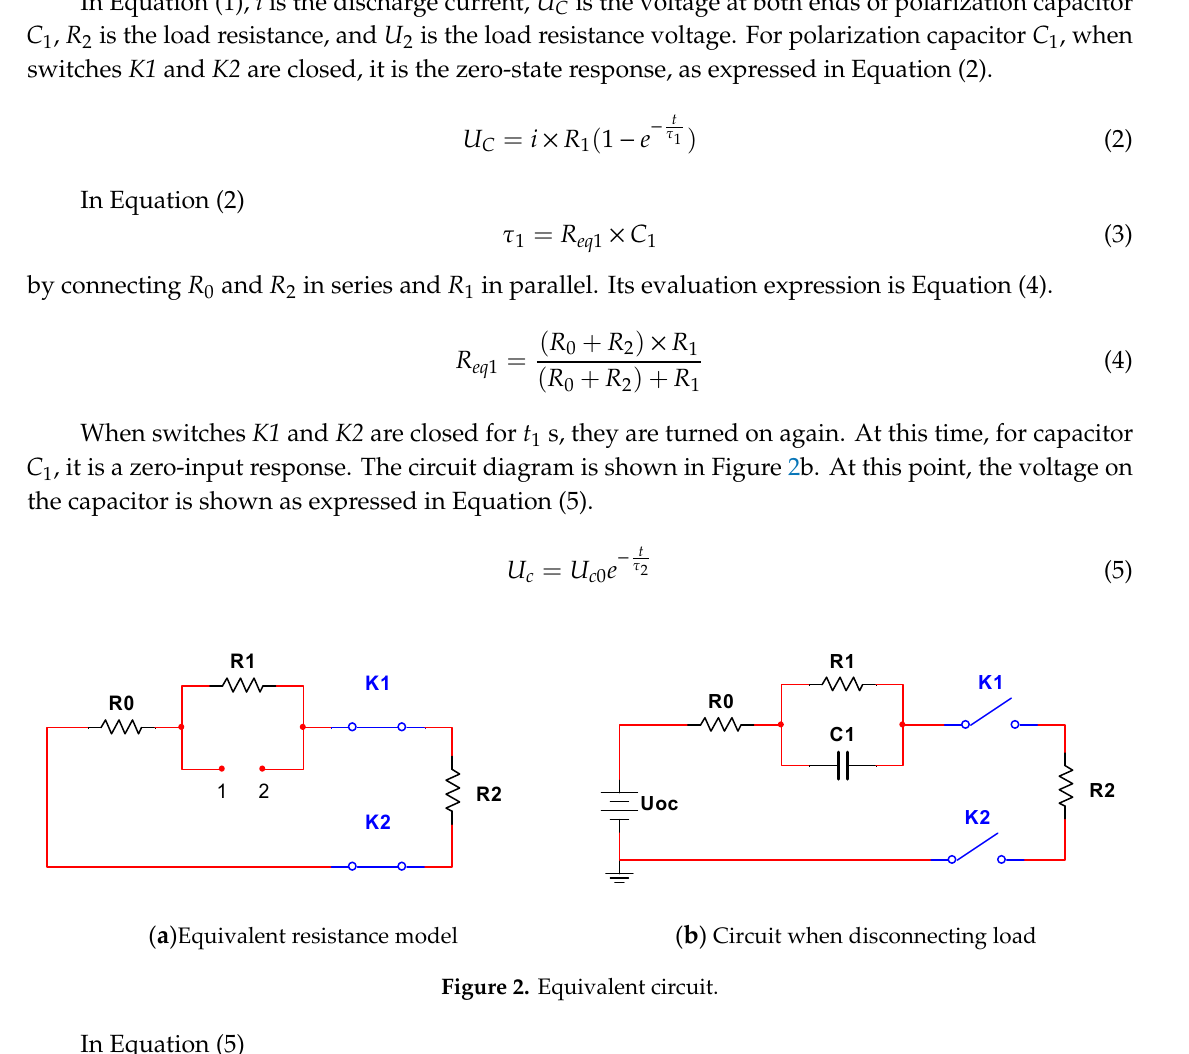
Figure 2. Equivalent circuit.